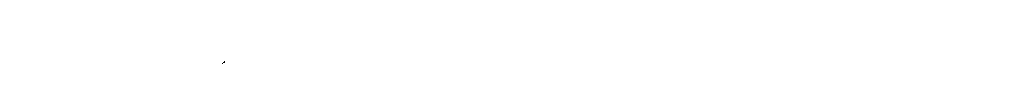
Figure 3: Performance ofE2 and C2 on Reading Tasks and Talking Tasks at each Phase of